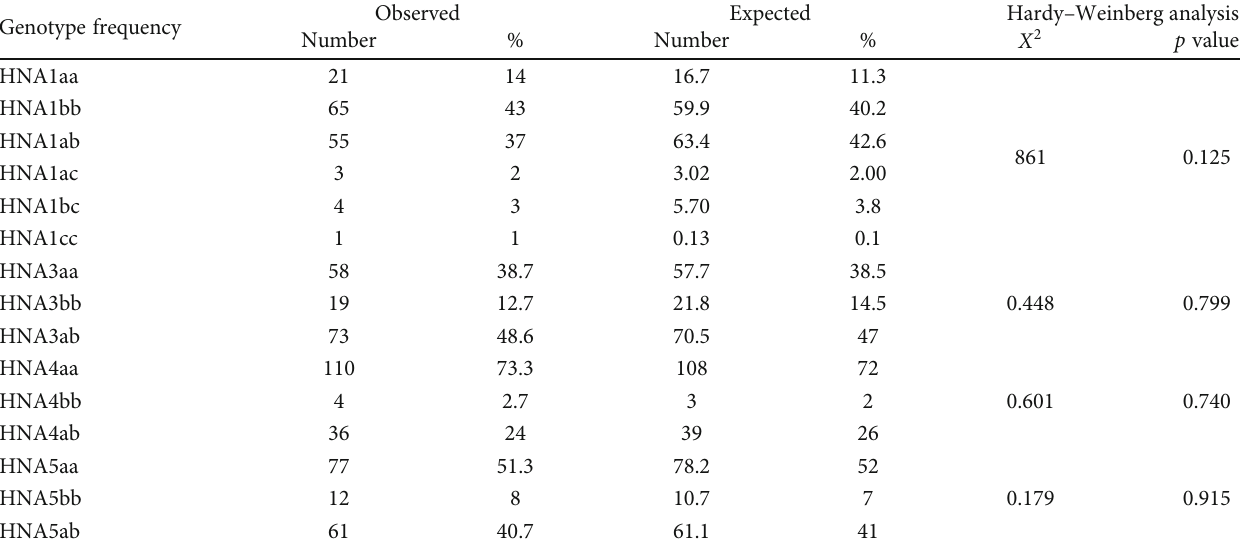
Table 4: The distribution of HNA genotype frequencies. HNA genotype frequency distribution in the Iranian population tested for the deviation of Hardy – Weinberg